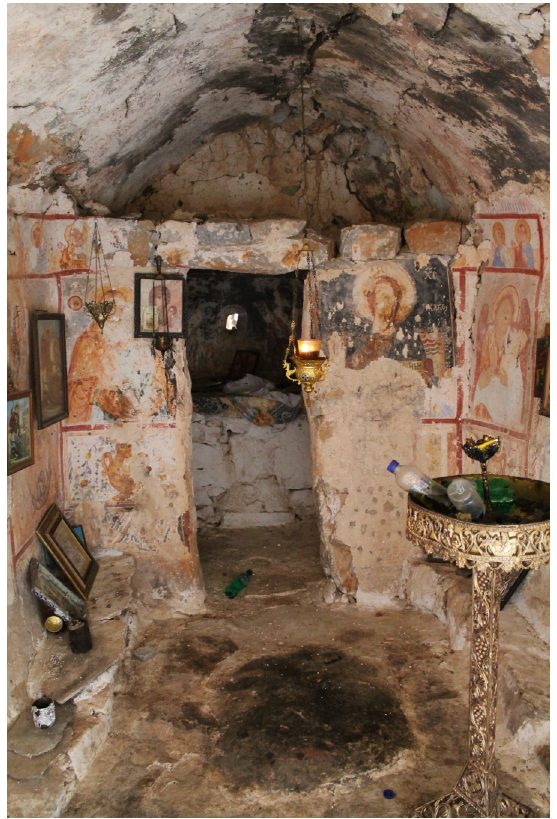
Figure 1. Material signs of the active maintenance of sacred infrastructure: a burning candle, empty water bottles, and framed modern icons in the 13 th -century church of Agios Georgios, Paliochori (June